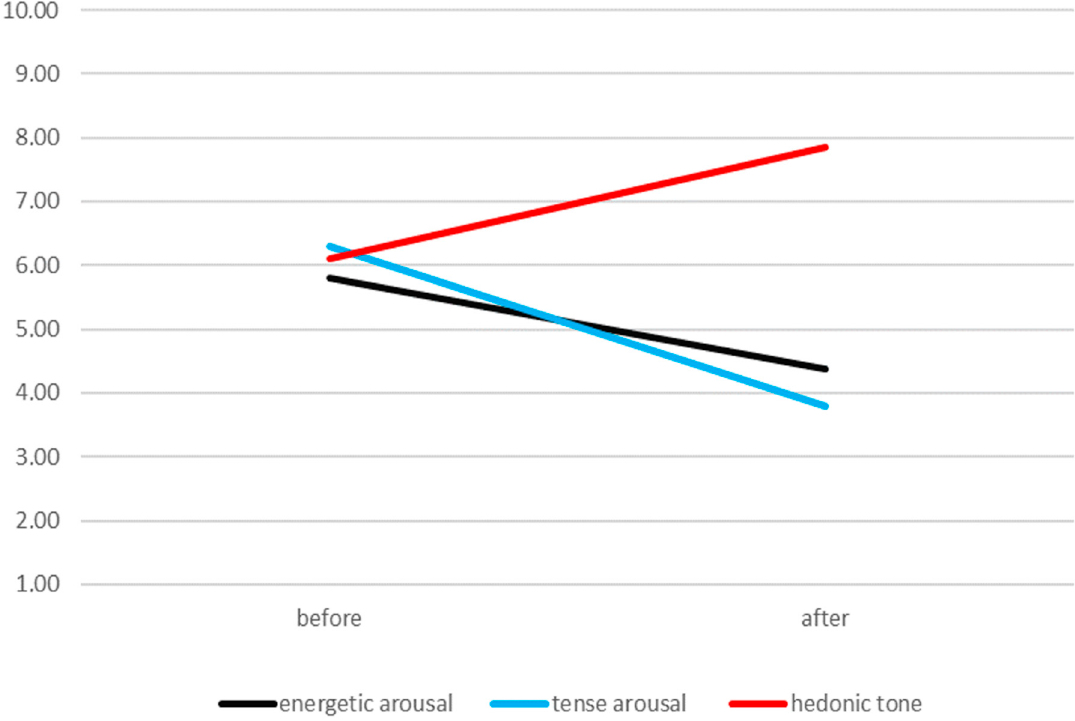
Figure 1. Changes in mood before and after running 100 km.